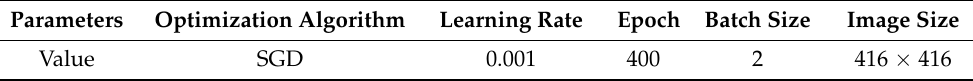
Table 3. Training parameter